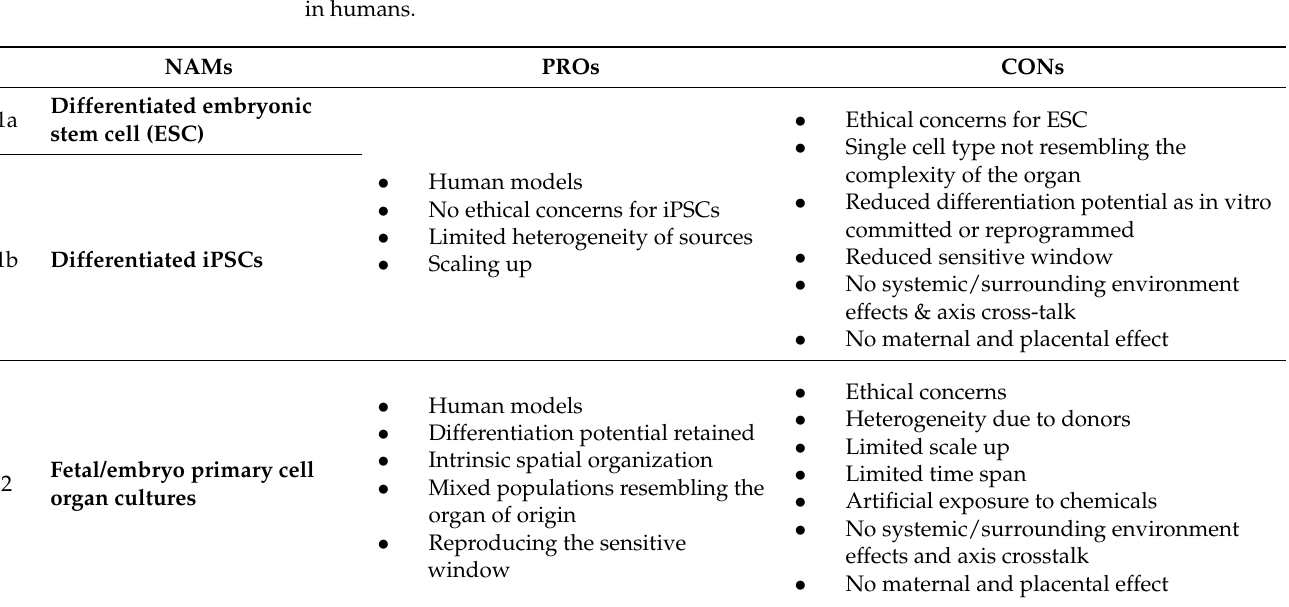
Table 3. Pros and cons of the different alternative models for assessing developmental toxicity in